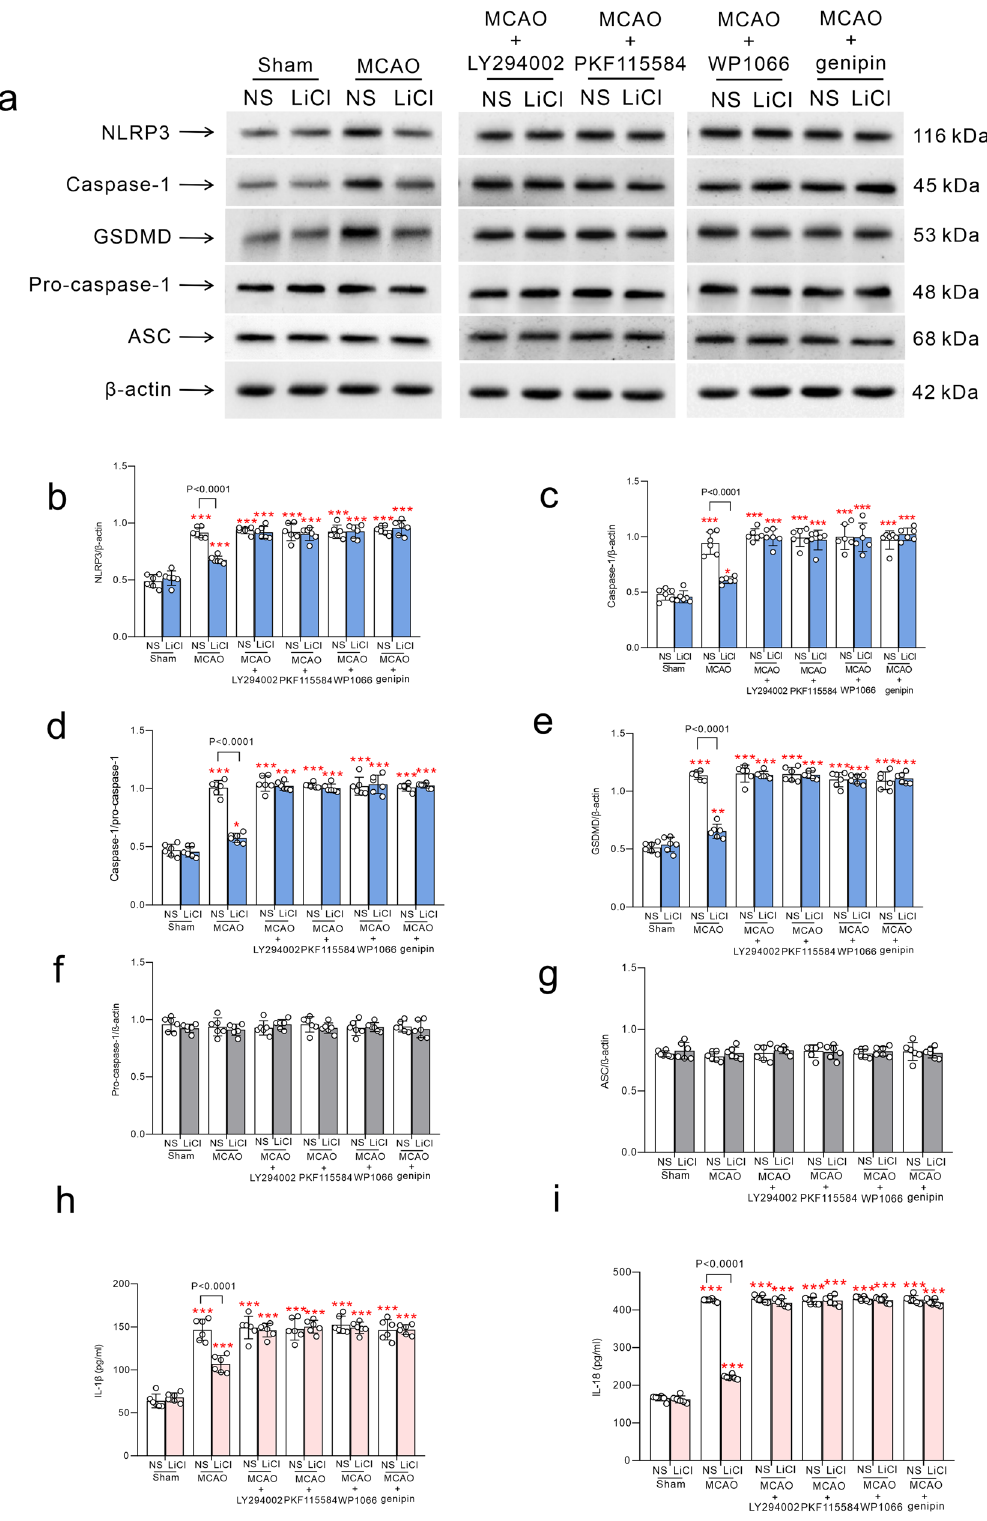
Fig. 6 Mechanism of Li + action on NLRP3 and GSDMD following ischaemia-reperfusion. a Representative protein bands of NRLP3, caspase-1, GSDMD, pro-caspase-1, ASC and β -actin (the house-keeping protein) in neurones. The normalised intensities of NLRP3, caspase-1, GSDMD, pro-caspase-1 and ASC by β -actin and the ratio of caspase-1 and pro-caspase-1 were shown in b – g , respectively. The levels of IL-1 β and IL-18 measured by ELISA were shown in h and i . The columns were calculated and plotted as mean ± SD. N = 6 per group. Two-way ANOVA for comparisons including more than two groups; unpaired two-tailed t -test for two group comparisons. * p < 0.05, ** p < 0.01, *** p <